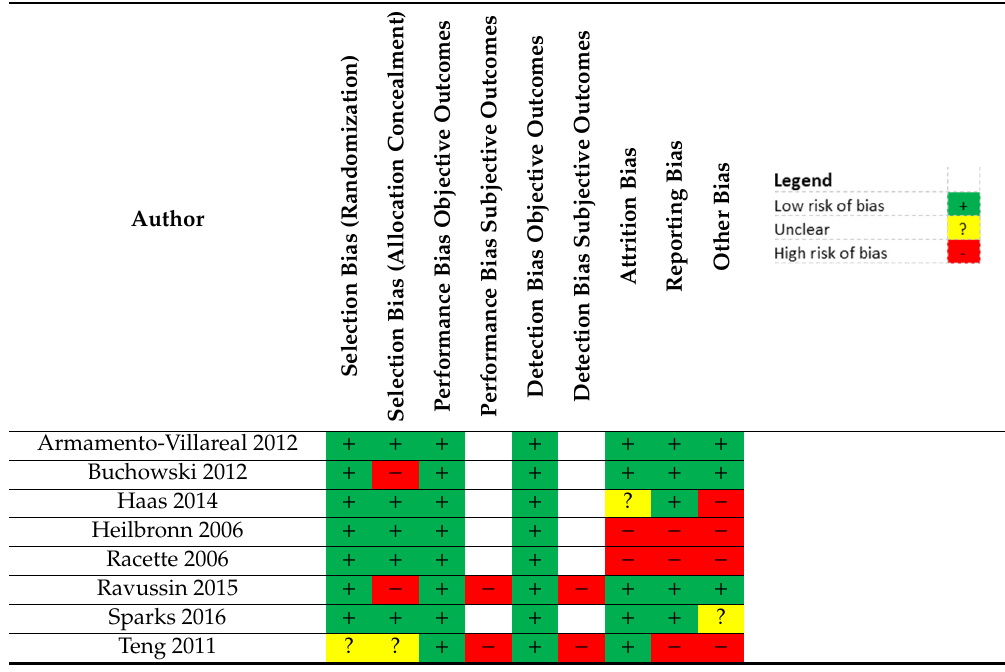
Table 2. Risk of Bias within included RCTs. We used the Cochrane’s risk of bias tool [61]. Each dimension was evaluated by two blinding reviewers, with results of concordance being here presented.